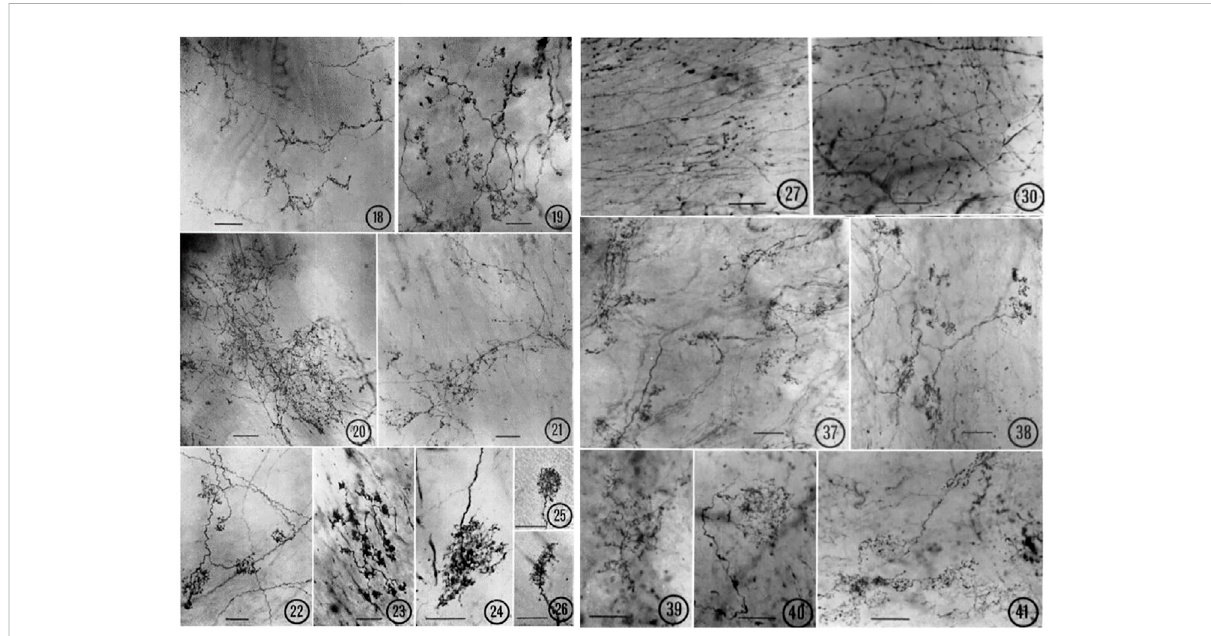
FIGURE 2 Various types of atrial receptors. 18 – 21 are diffuse CUEs. 18, cat left atrial endocardium (tending toward compact, intermediate type); 19, cat right atrial endocardium; 20, lamb right atrial endocardium; 21, monkey left atrial endocardium. 22 – 26 are compact CUEs. 22, dog left atrial endocardium; 23, monkey left atrial endocardium; 24, lamb left atrial endocardium; 25, cat right atrial endocardium; 26, cat left atrial endocardium. Sensoryend-nets intheendocardiumofrightinterventricularseptum (27,cat)andinthemitral valve(30,Monkey).CUEsintheadventitiaofthe aortic arch (37, cat; 38, lamb; 39, monkey; 40 – 41, Dog). [Figures (Miller and Kasahara,